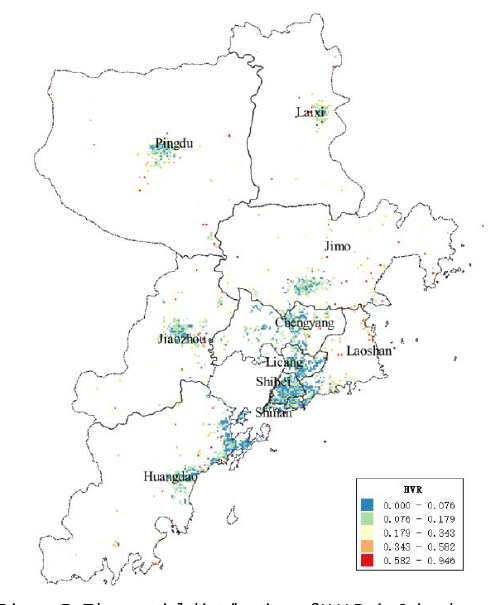
Figure 5. The spatial distribution of HVR in Qingdao In Figure 5, it is clear that the downtown districts and county center areas in Qingdao city (blue grids in the map) have few vacant houses. As a whole, the overall vacancy rate in the southeastern coastal area is relatively low. Simultaneously, the concentration of housing is high and the housing density is relatively large. And HVR in other regions shows the tendency of the low value accumulation in the downtown area and the increasing trend towards the outer suburbs. Meanwhile the suburban and scenery regions (red and orange grids) by the side of the sea and mountains are likely to be the most vacant part of the city. Considering the relatively high price of real estates and the inconvenience in commute and living, it is reasonable that most people would prefer to live in other